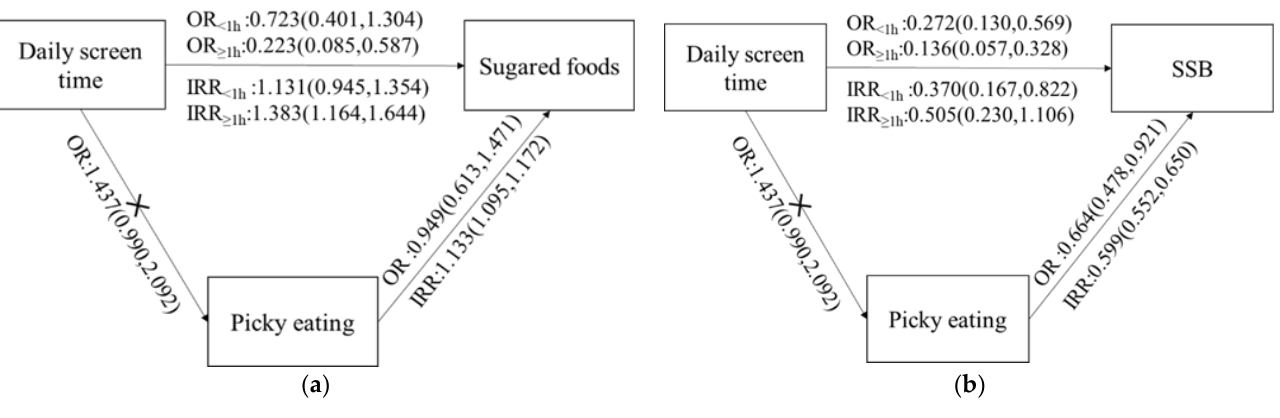
Figure 1. ( a ) Relationship between daily screen time, picky eating, and the consumption frequency of sugared foods. ( b ) Relationship between daily screen time, picky eating, and the consumption frequency of SSBs. IRR, incidence rate ratio; OR, odds ratio; SSB s , sugar-sweetened